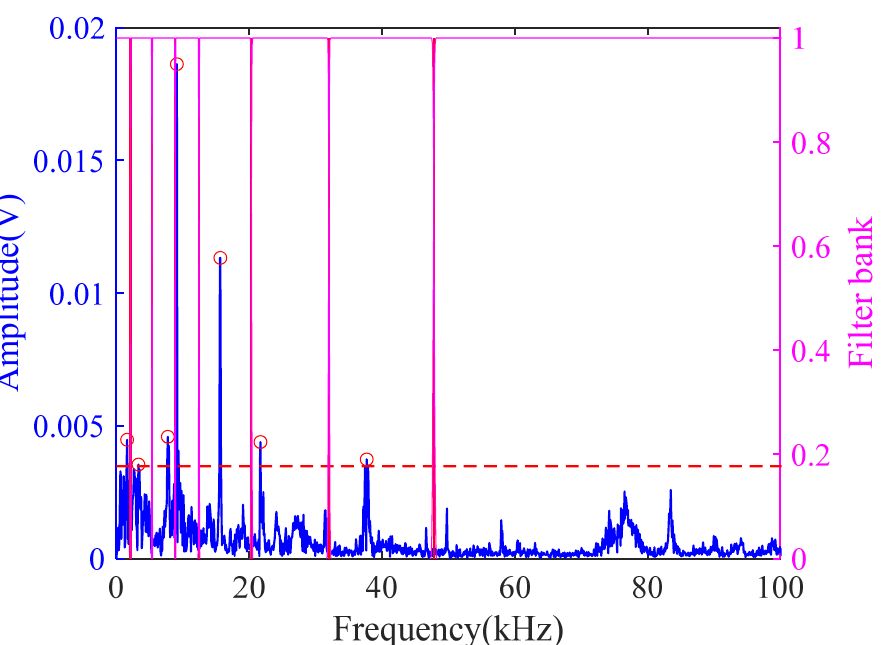
Figure 4. Adaptive segmentation result of the Fourier axis based on DFT and closing operation.